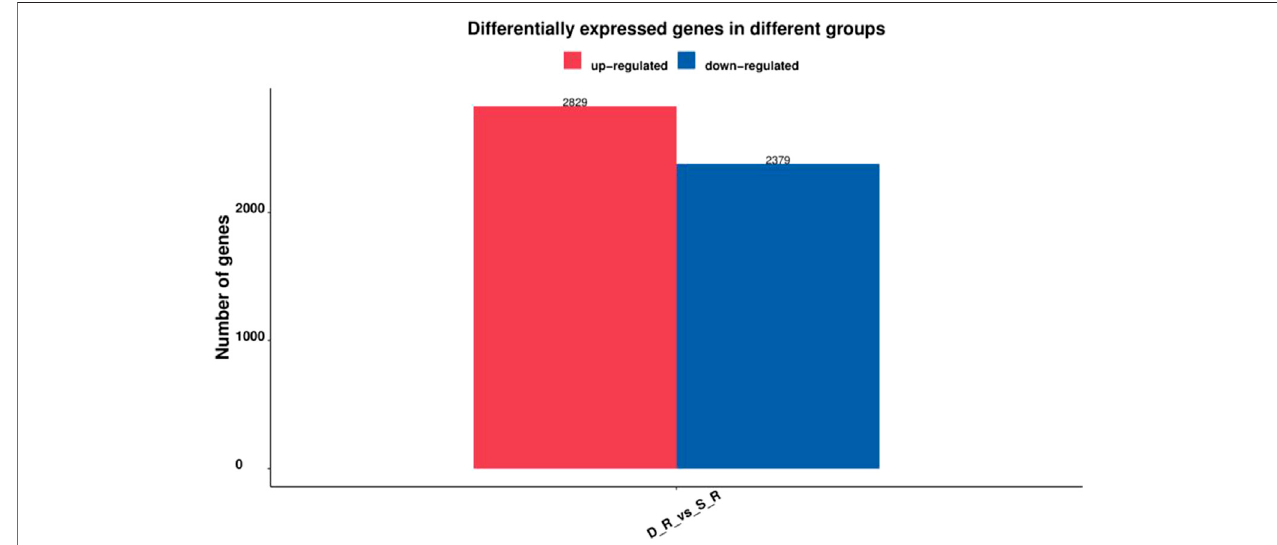
FIGURE 5 | Number of DEGs in the single-head root and double-head root SD.